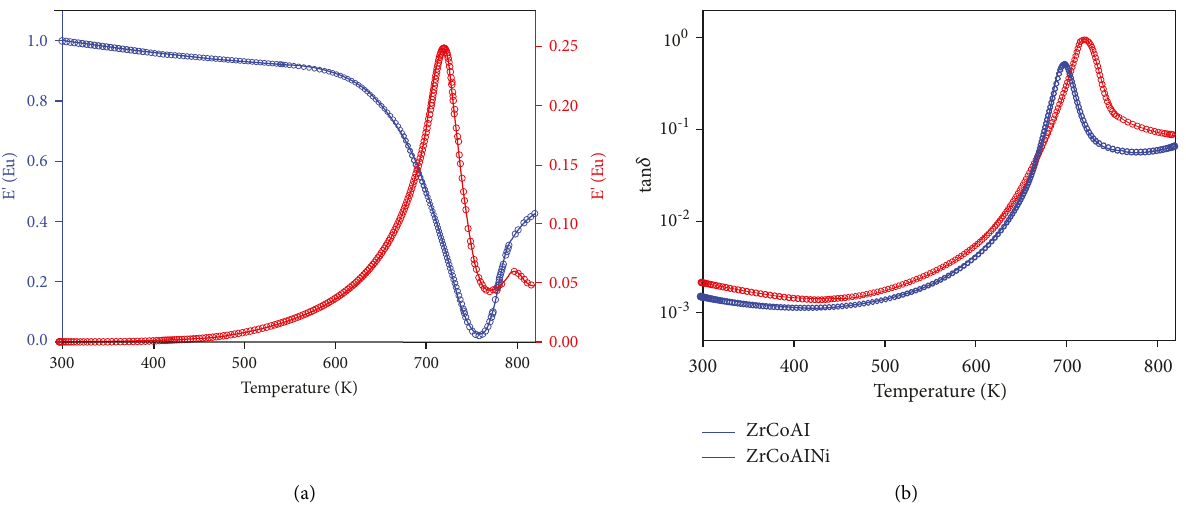
Figure 2: (a) Normalized E ″ and E ′ values for the ZrCoAl sample. (b) Loss factor as a function of temperature for ZrCoAl and